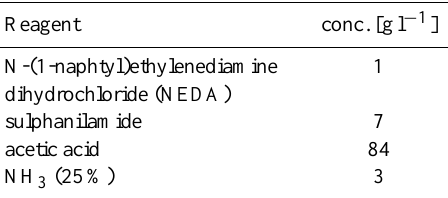
Table 1. Optimized composition of the Griess-Saltzman reagent